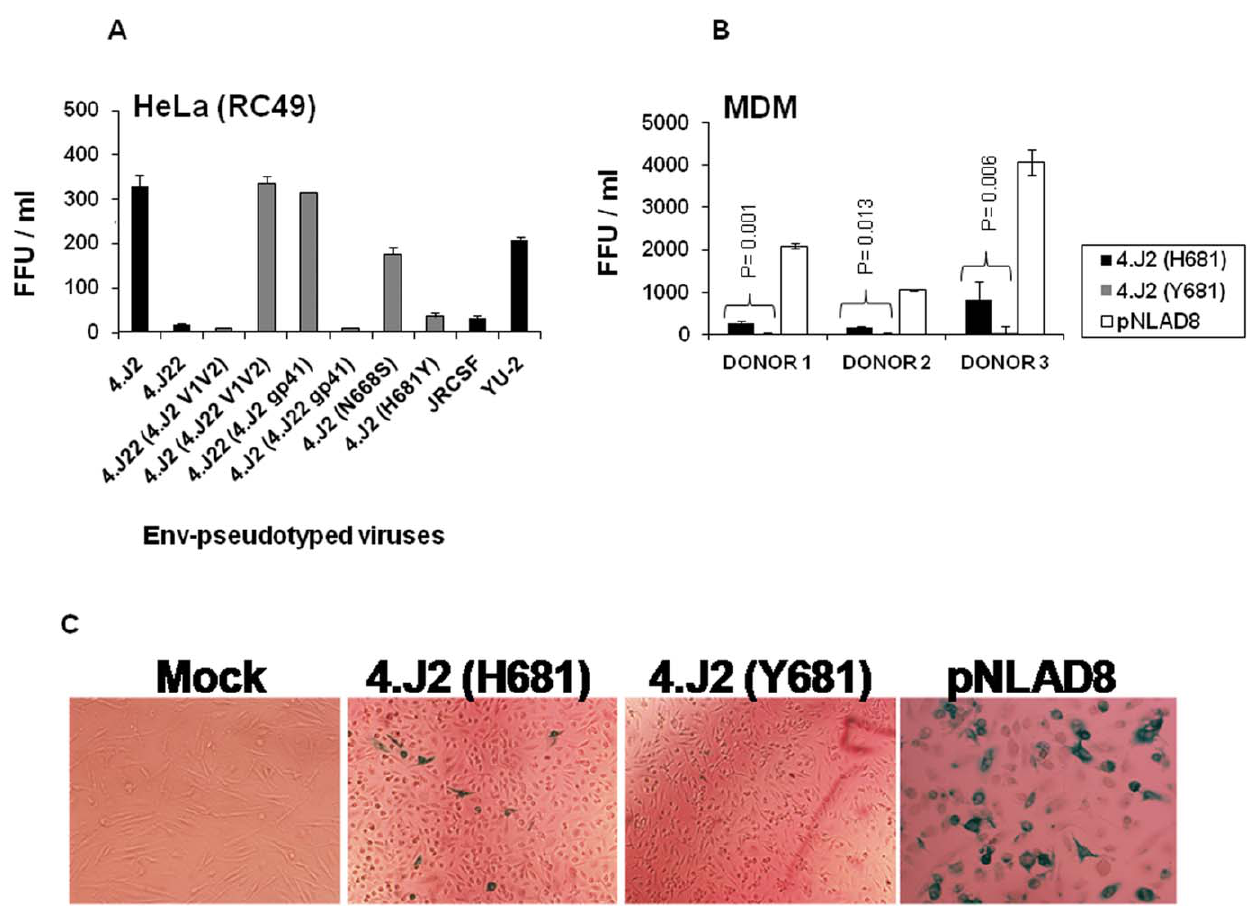
Figure 6. Infectivity of Env-pseudotyped viruses in cells expressing low CD4. Infectivity of Env-pseudotyped viruses was tested in (A) HeLa cells expressing low CD4 (RC49) [48]and (B) monocyte-derived macrophages (MDM). In both cases, effector cells were infected with Env-pseudotyped viruses with equal infectious units and the infectivity was assessed by immunostaining intracellular p24 and expressed as focus forming units (FFU) on Y-axis in a b -galactosidase assay as described earlier [46,51]. (C). The b -galactosidase positive cells (in blue) representing MDM (from one donor) expressing intracellular p24 were scored as focus forming units (FFU) to assess the relative infectivity. For MDM assays, macrophage tropic pNLAD8 was used as positive. In HeLa (RC49) cells, YU2 and JR-CSF were used as